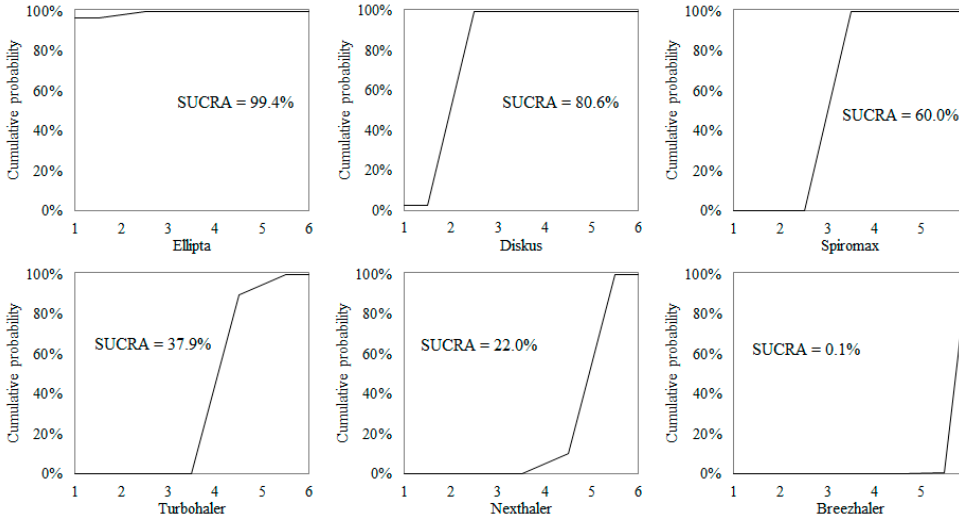
Figure 2. Cumulative ranking probability plots from the six DPIs.